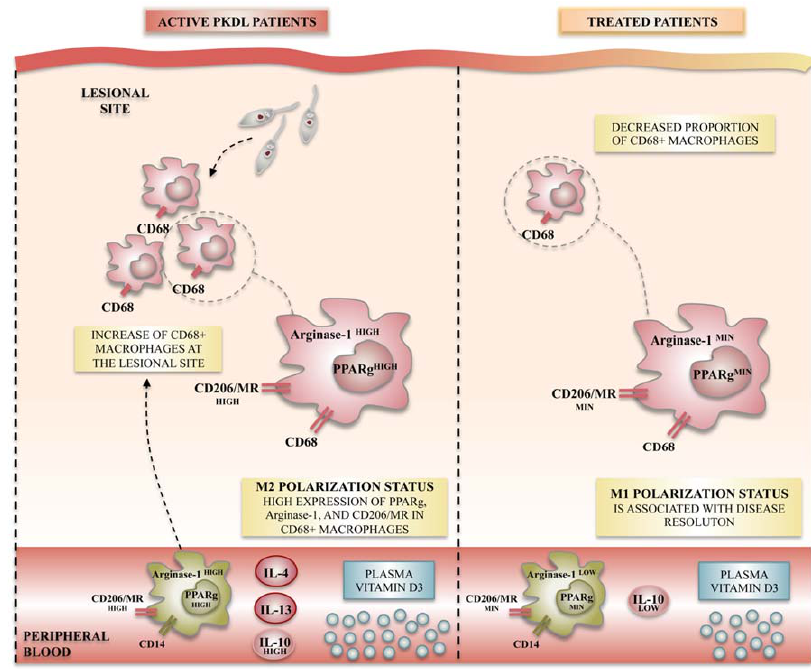
Figure 2. Macrophage polarization status observed in post-kala-azar dermal leishmaniasis (PKDL) patients during acute disease and after treatment. Leishmania infection in humans has been studied in PKDL patients, in which features of M2-like polarization have been observed in both lesion sites and peripheral blood. M2-like polarization is characterized by the increased mRNA and/or protein expression of specific M2-like markers such as the nuclear peroxisome proliferator activated receptor γ (PPAR γ ), the arginase-1 receptor, and the membrane mannose receptor CD206/mannose receptor (MR). After treatment, disease resolution is characterized by an M1-like profile repolarization, evidenced by the decreased expression of M2-like